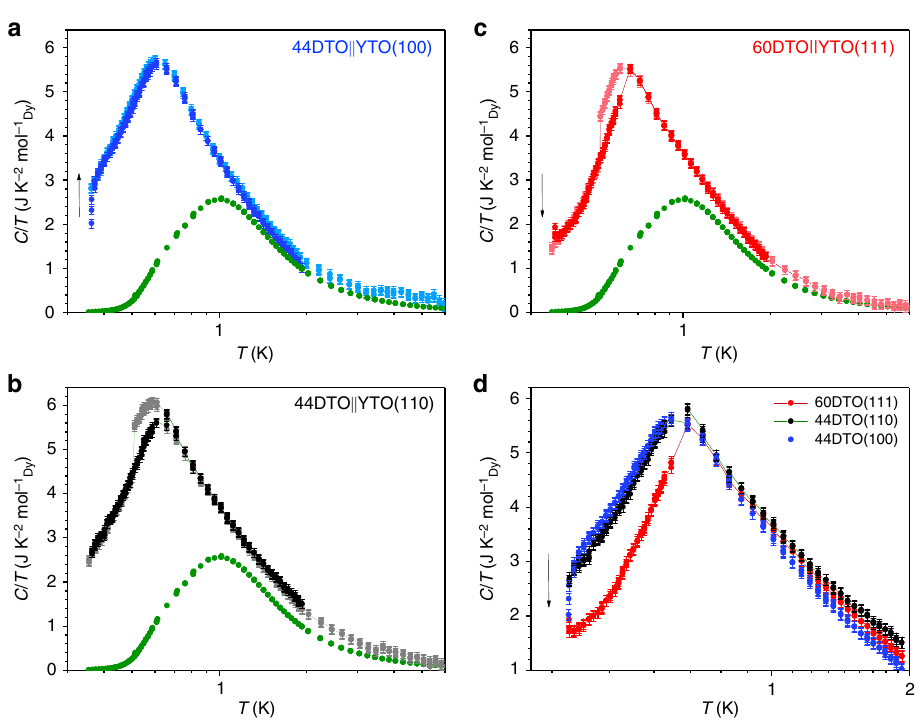
Fig. 3 Speci fi c heat. Bulk single crystal DTO (green) is also reported for comparison. Error bars represent estimated maximum systematic error. Note that for the bulk sample, error bars are within the symbol size. a 44DTO||YTO(100), measured during cooling (light) and heating (dark). No hysteresis or discontinuity is visible in the temperature range explored. b 44DTO||YTO(110), measured during cooling (light) and heating (dark). Here, a hysteresis loop opens up below T = 0.75 K and a sharp discontinuity is detected upon cooling at T = 0.510(2) K. c 60DTO||YTO(111), measured during cooling (light) and heating (dark). Here, a hysteresis loop opens up below T = 0.75 K and a sharp discontinuity is detected upon cooling at T = 0.520(2) K. d Comparison between samples grown along different orientations, to emphasise how all the curves are superimposed above T = 0.75 K. DTO Dy 2 Ti 2 O 7 , YTO Y 2 Ti 2 O 7